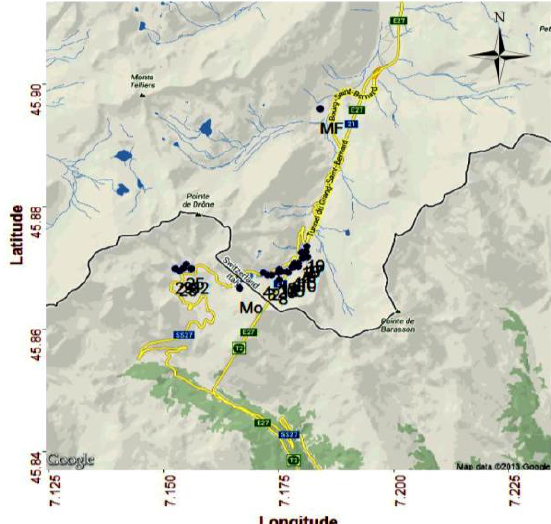
Figure 2. The location of utilized data-sets in this research, where ‘MF’ presents the MetoSwiss forecast grid point and ‘Mo’ illustrates the MetoSwiss observation station and two clusters show the WSN small and big clusters in geographic coordinate